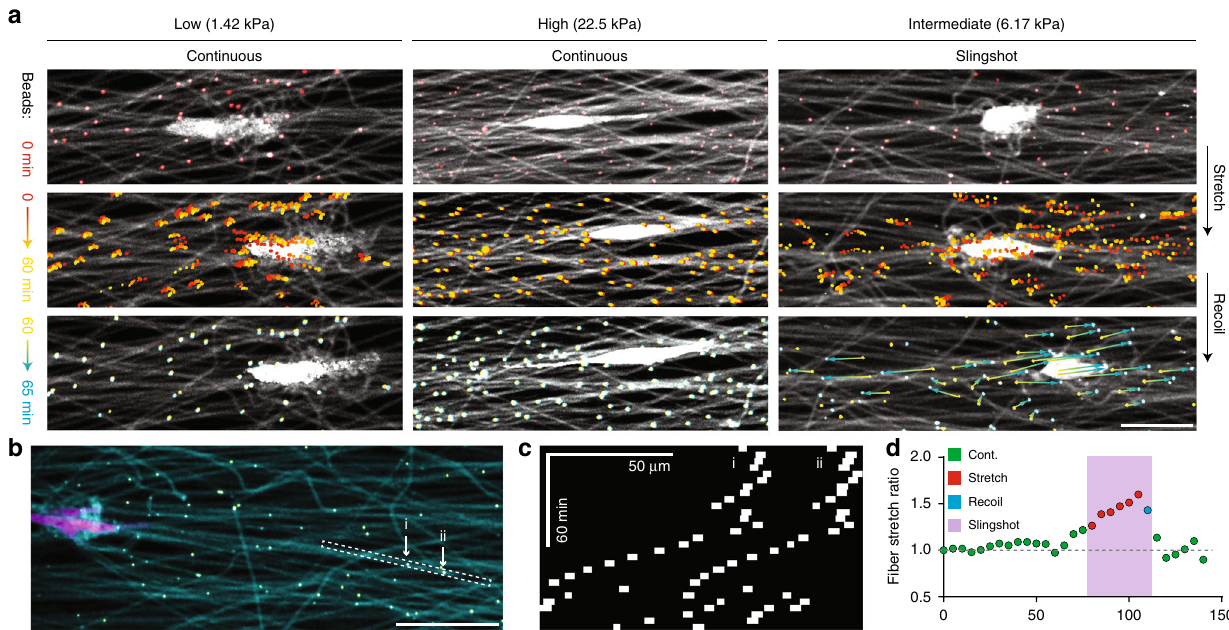
Fig. 4 Slingshot migration involves stretch and recoil of matrix fi bers. a Representative time-lapse images of fi bers containing fl uorescent microspheres, used as fi ducial markers to examine matrix deformations underlying continuous and slingshot migration (scale bar: 50 µ m). b Composite confocal fl uorescence image of an NIH3T3 within an intermediate stiffness matrix (matrix fi bers (cyan), cytoplasm (magenta), and fi ber-embedded beads (yellow); scale bar: 50 μ m). c Kymograph of a pair of microspheres embedded within the same fi ber, as indicated in b used to determine fi ber stretch ratio ( d ) (relative to initial distance between beads) as a function of